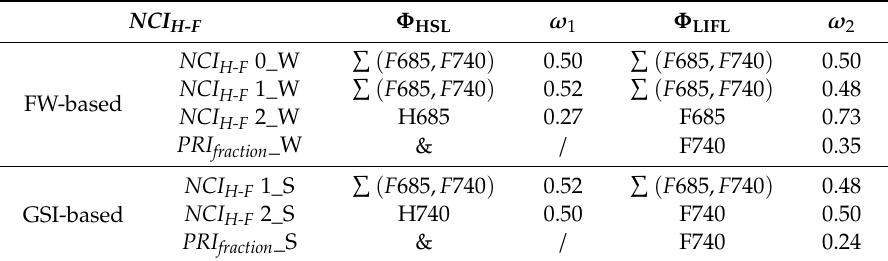
Table 3. Values of ω 1 and ω 2 in Equation (1) calculated with FWs and GSIs for four spectral variables, namely (H685 H740) and (F685